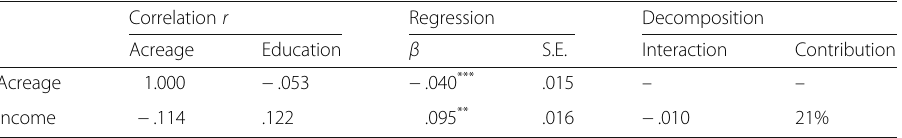
Table 3 Contribution rate of the income and substitution